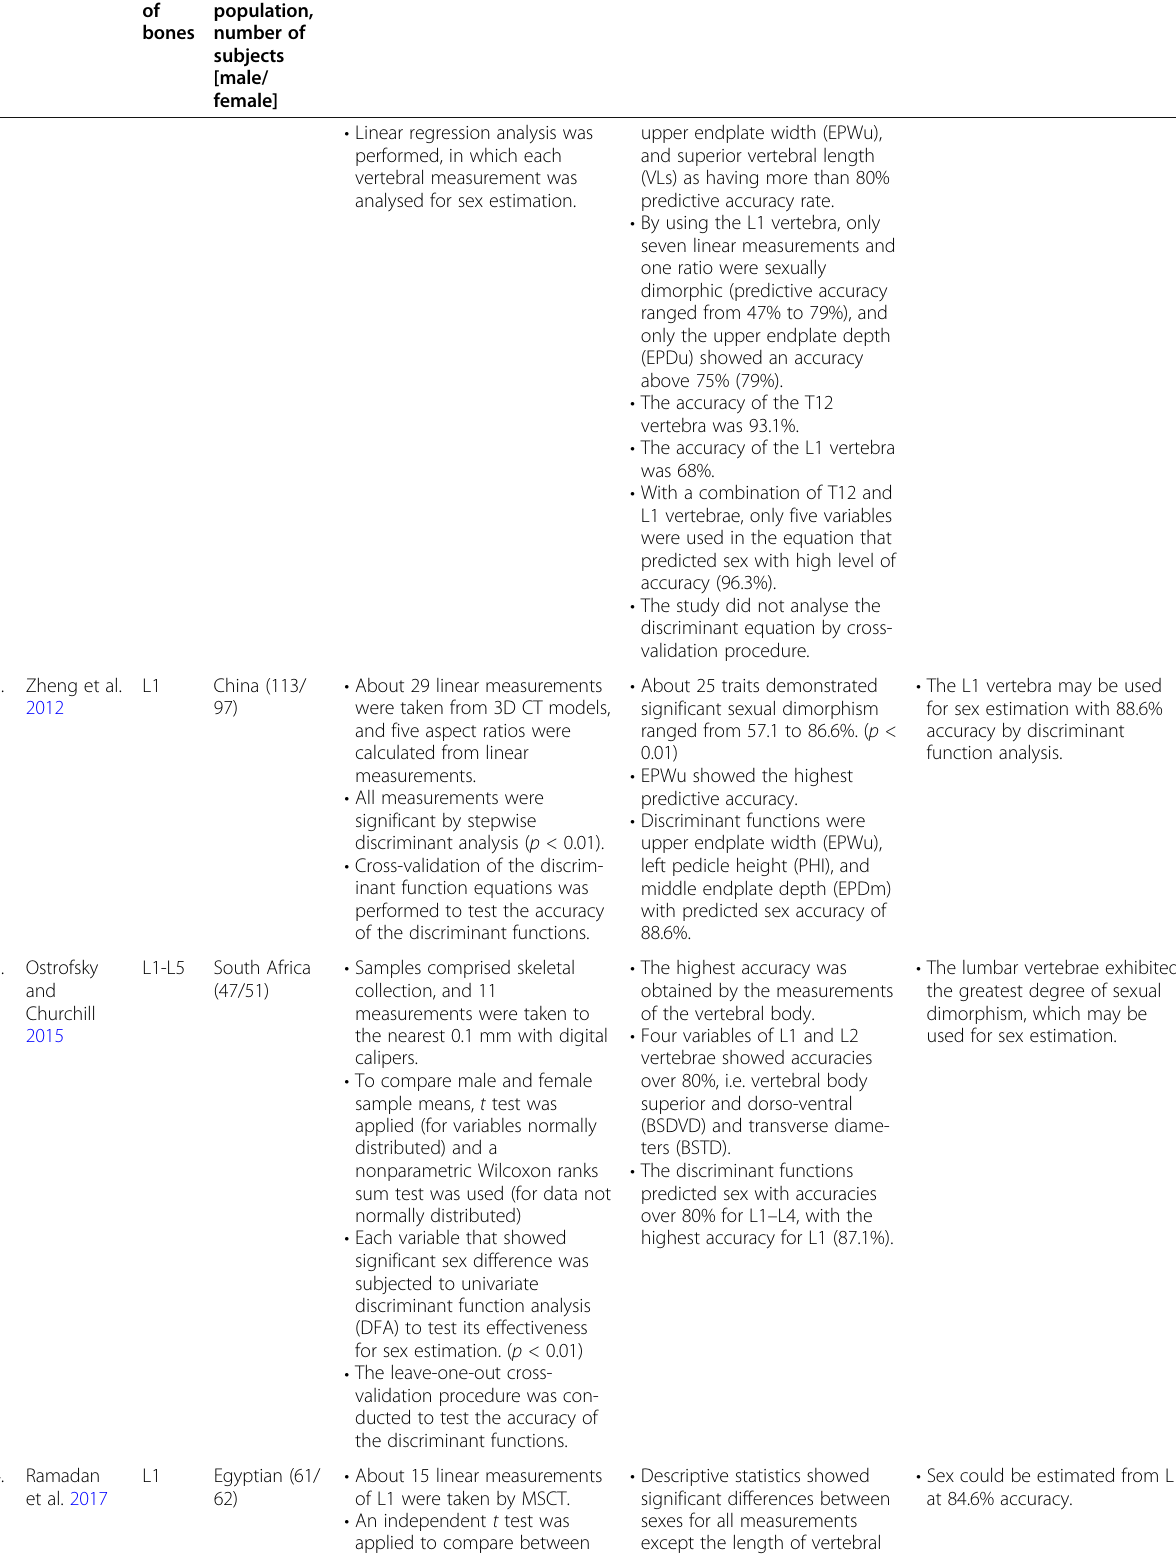
Table 1 The descriptive studies on sexual dimorphism in vertebral bone (Continued) No.